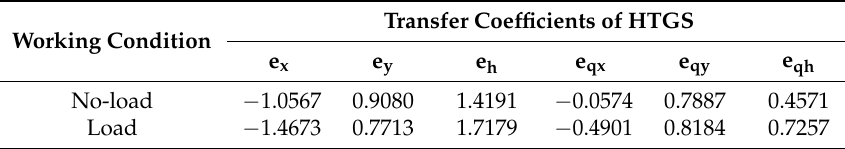
Table 9. Transfer coefficients of HTGS on two working conditions.